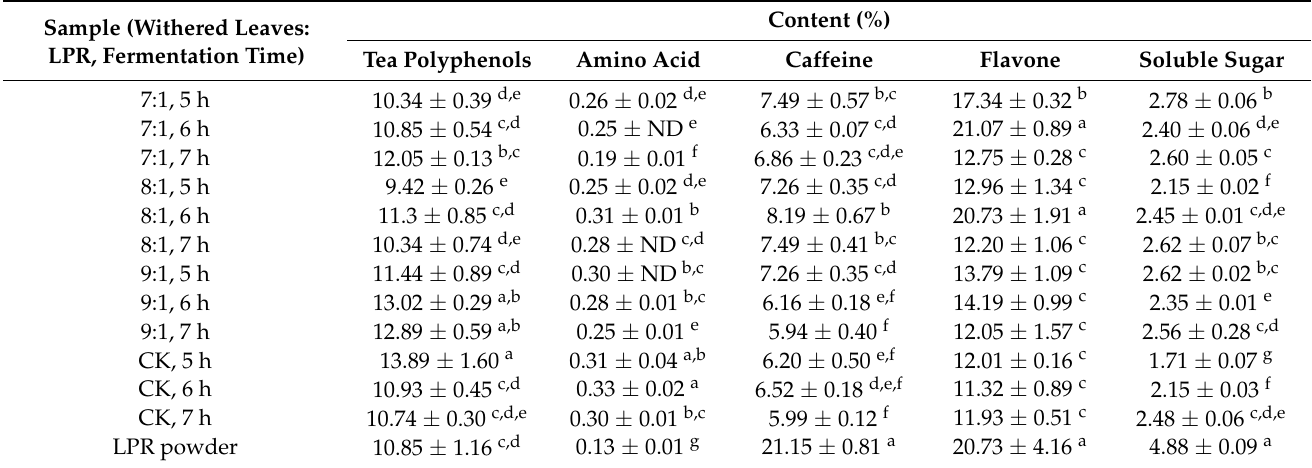
Table 4. Compositions of